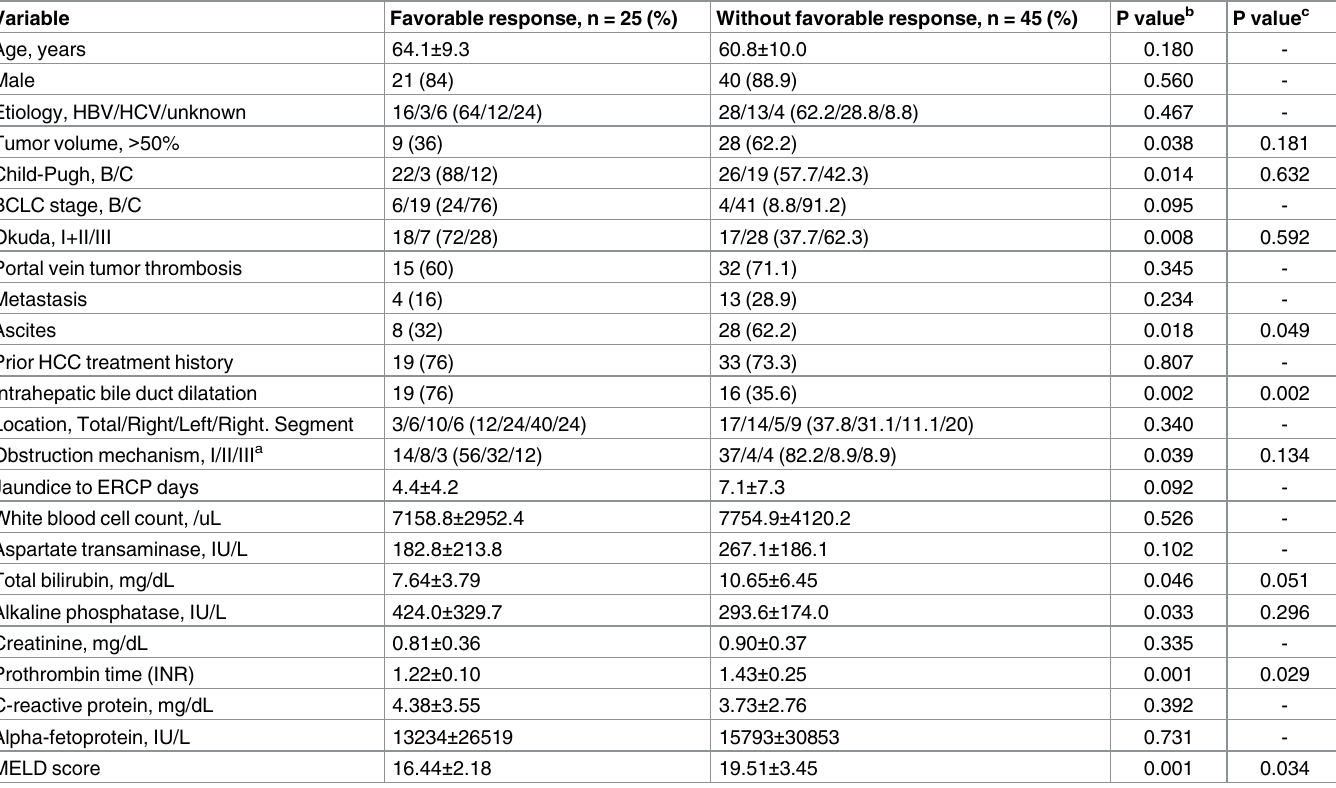
Table 2. Clinical factors associated with complete response after biliary